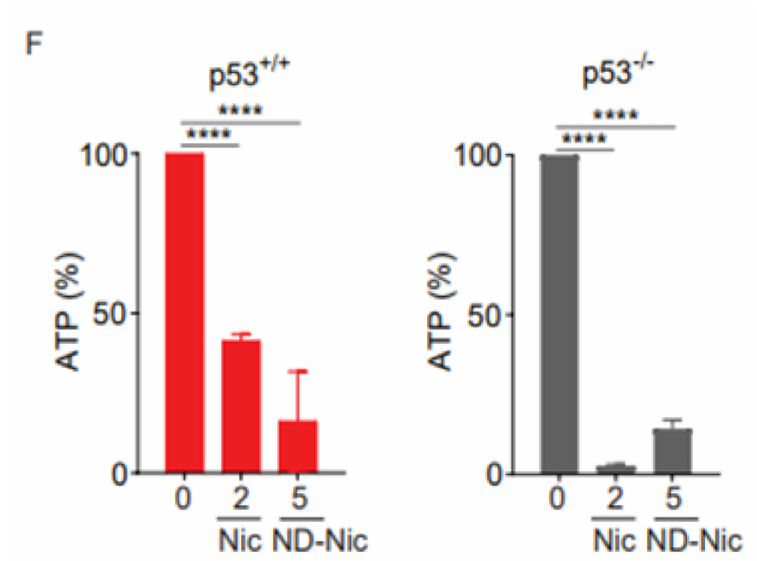
Figure 2. Nitro-deficient niclosamide analogue shares similar mitochondrial uncoupling activity with niclosamide ( A ) Schematics of mitochondrial membrane potential determined by the mean intensity of JC-1 (green) over J aggre- gates (red). Healthy mitochondrial membrane potential enables the inward transport of JC-1 to form J aggregates while depolarised mitochondrial membrane results in the accumulation of JC-1 outside of the mitochondria with little to no J aggregates formation. Representative immunofluorescence images and quantification of JC-1 to J aggregates ratio in human colon carcinoma HCT116 cells treated with either 0.4% DMSO or 50 µ M carbonyl cyanide 3-chlorophenylhydrazone (CCCP) for 3 h. White scale bar at 50 µ m. Representative immunofluorescence images and quantification of JC-1 to J aggregates ratio in HCT116 cells treated with either ( B ) 0.4% DMSO and 2 µ M Nic or ( C ) 0.4% DMSO and 7.5 and 15 µ M ND-Nic for 3 h. White scale bar at 50 µ m. Error bars represent ± SD of at least 3 independent experiments. t -test was used to determine significance (*, p < 0.05; **, p < 0.01; ***, p < 0.001; ****, p < 0.0001). ( D ) Oxygen consumption rate (OCR) measured in HCT116 p53 +/+ and HCT116 p53 − / − cells using Seahorse Mito Stress Assay by adding ATP synthase inhibitor, oligomycin A and mitochondrial uncouplers, 0.5 µ M FCCP or 7.5 µ M ND-Nic. ( E ) Bar graph of maximal respiration of HCT116 p53 +/+ and HCT116 p53 − / − induced by the addition of 0.5 µ M FCCP and 7.5 µ M ND-Nic. Error bars represent the ± SD of at least 3 independent experiments. t -test was used to determine significance (ns, p > 0.05). ( F ) Percentage of ATP production in 0.4% DMSO, 2 µ M Nic and 5 µ M ND-Nic treated HCT116 cells for 48 h. Error bars represent ± SD of at least 3